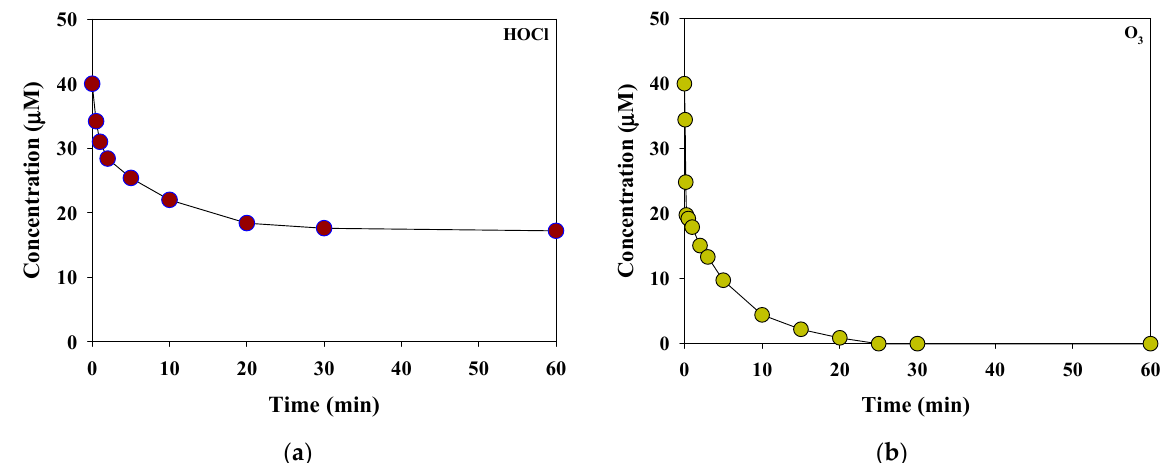
Figure 2. Consumption kinetics of the selective oxidants, ( a ) HOCl and ( b ) O 3 , in the rainwater sample (initial concentration of each oxidants = 40 μ M, reaction time = 1 h, temperature = 25 °C, pH = 6.6).